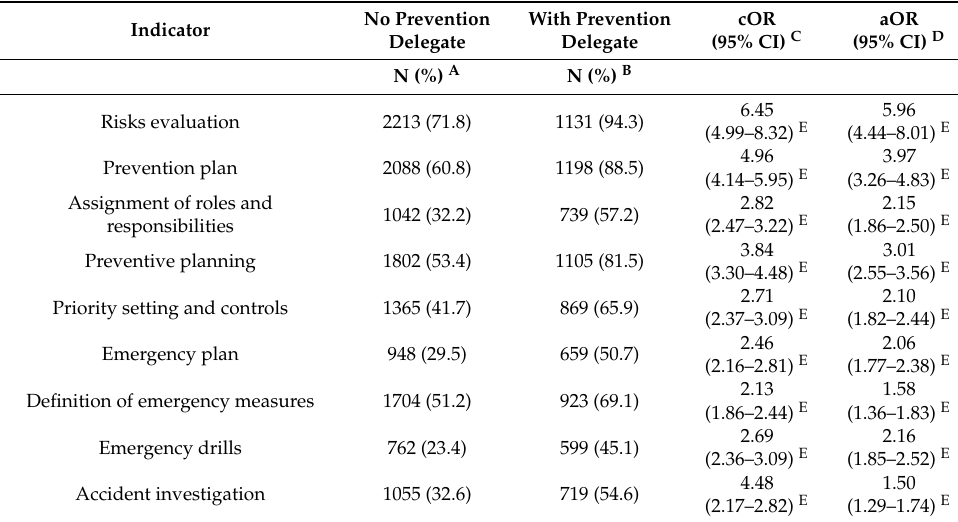
Table 3. Prevalence and adjusted logistic regressions between the presence of unitary prevention delegates and preventive management indicators.